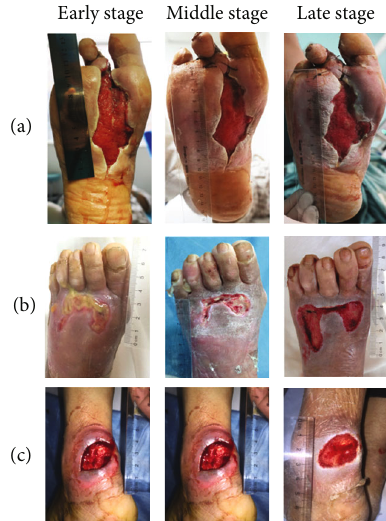
Figure 1: Changes of ulcer wounds in diabetic foot patients during di ff erent treatment periods. (a) is the ulcer wound changes in the lesion site of patients with No. 1 diabetic foot after antimicrobial peptide treatment in the early, middle, and late stage; (b) is the ulcer wound changes in the lesion site of patients with No. 2 diabetic foot after antimicrobial peptide treatment in the early, middle, and late stage; (c) is the ulcer wound changes in the lesion site of patients with No. 3 diabetic foot after antimicrobial peptide treatment in the early, middle, and late stages. The initial ulcer areas of the three patients were about 40cm 2 , 10cm 2 , and 6 cm 2 , respectively, and the amount of wound exudate was between 100 μ L and 2